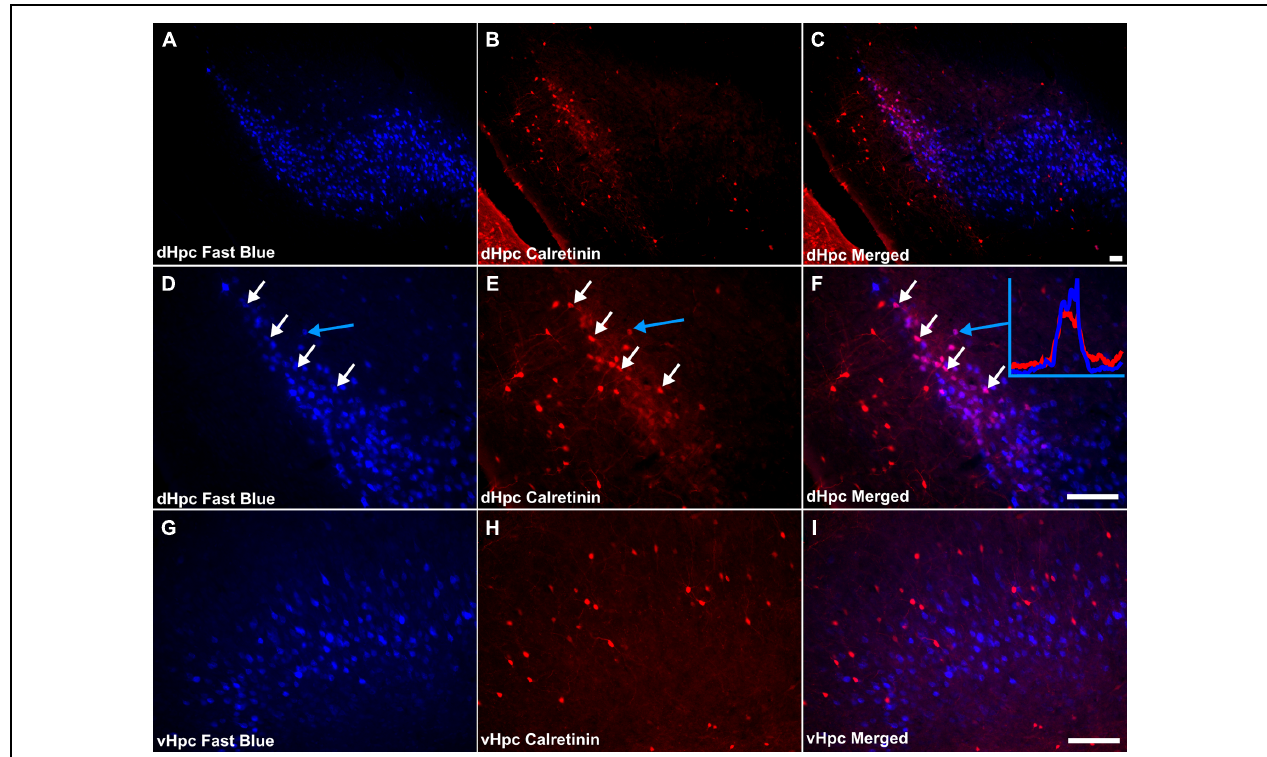
FIGURE 11 | Calretinin/hippocampal formation: (A,D,G) Fluorescent photomicrographs showing retrograde Fast Blue cell body label in the subicular cortices (dorsal subiculum and postsubiculum at low (50 × ) and high (200 × ) magnification, as well as the ventral subiculum (200 × ). (B , E , H) show fluorescent CR immunoreactivity in respective sections while (C , F , I) show retrograde Fast Blue label and CR immunoreactivity superimposed. Although largely sparse, or absent throughout the subicular cortices, a dense localized region of CR immunoreactivity was present in layer III of the